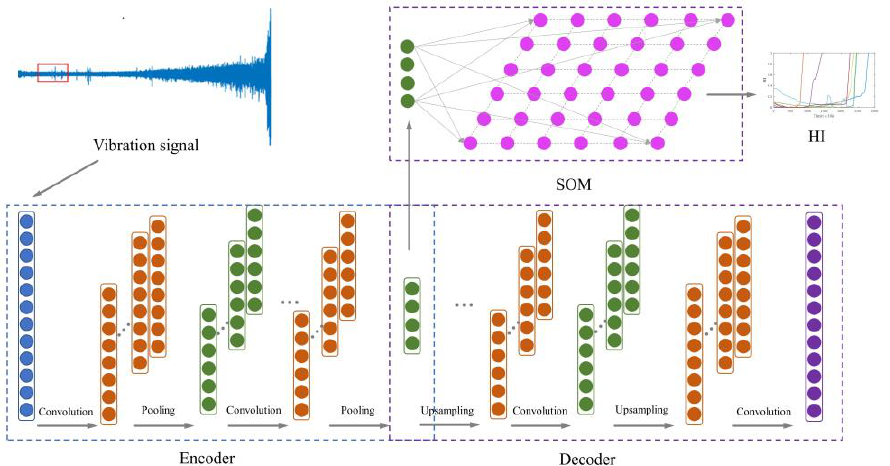
Figure 5. The process of the rolling bearing degradation modeling method.